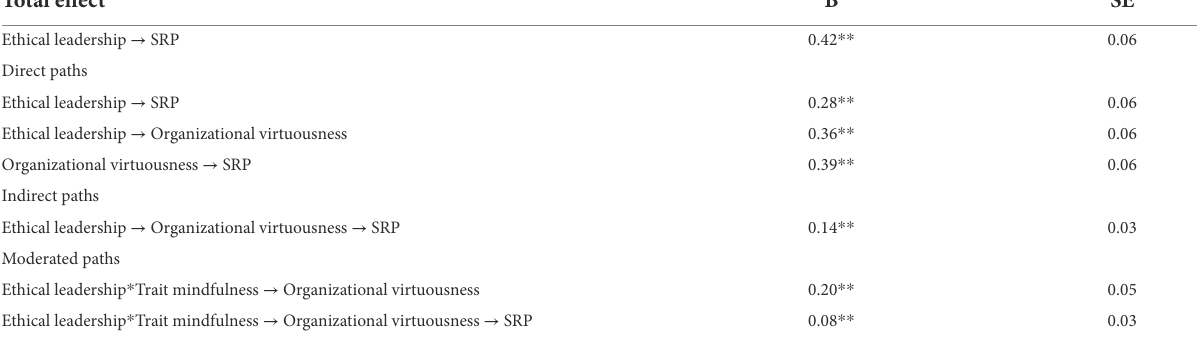
TABLE 3 Hypotheses